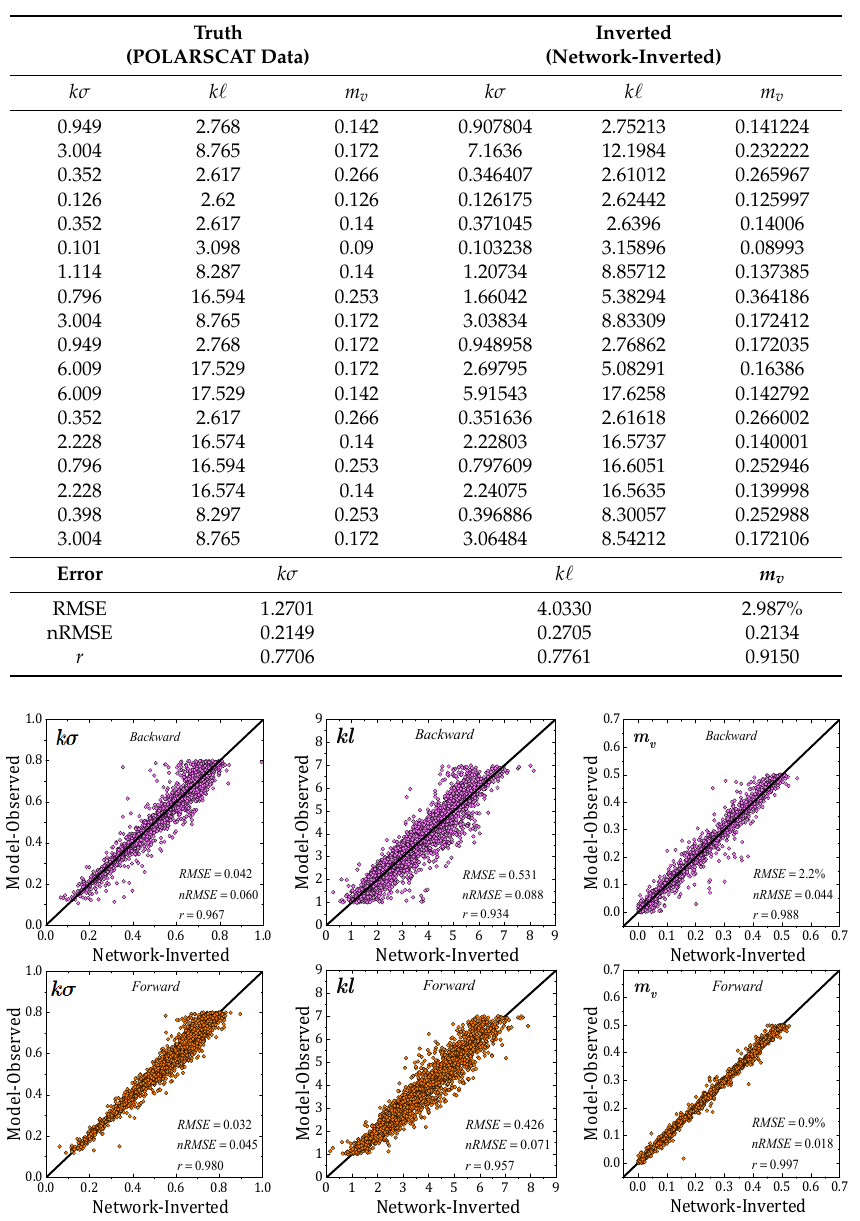
Table 4. Surface parameters between measured data (POLARSCAT) and DLNN inversion.